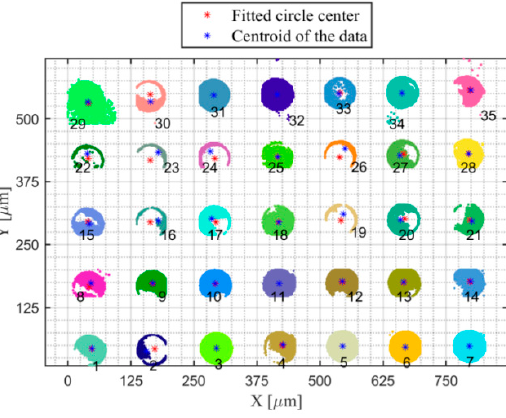
Figure 18. Comparison of the fitted circle center and the centroid of the data.